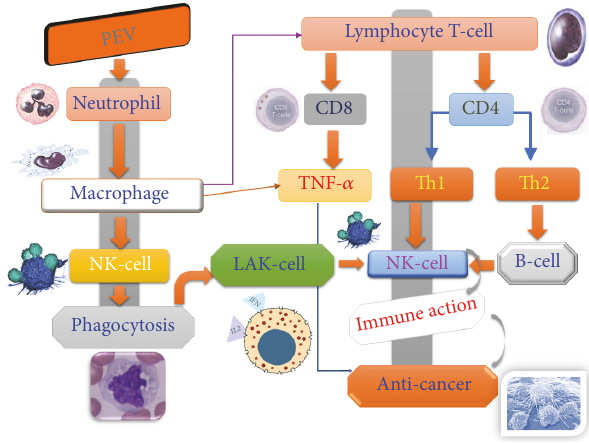
Figure 7: The mechanism of anticancer action of PEV. When PEV is taken into the body from the Peyer’s patch, it works strongly on hematopoieticstemcells. Hematopoieticstem cells differentiateinto bloodcelllineagesincludinggranulocytes,monocytes,and NKcells. PEV is an active substance such as lysozyme which is universally presentin body fluids. Humoral defense factorssuchas complement also selectively function in the area of foreign body entry. Next, accumulation of neutrophils from the blood and phagocytosis occurs, and subsequently, accumulation of macrophages is assisted, and phagocytosis of macrophages occurs.Macrophages also activate NK cells and release various cytokines. These things work together to affect the immune response. It is thought that PEV was absorbed into the body and led to antitumor by activation of immune cells that attack malignant tumor cells such as macrophages, NK cells, and TNF- 𝛼